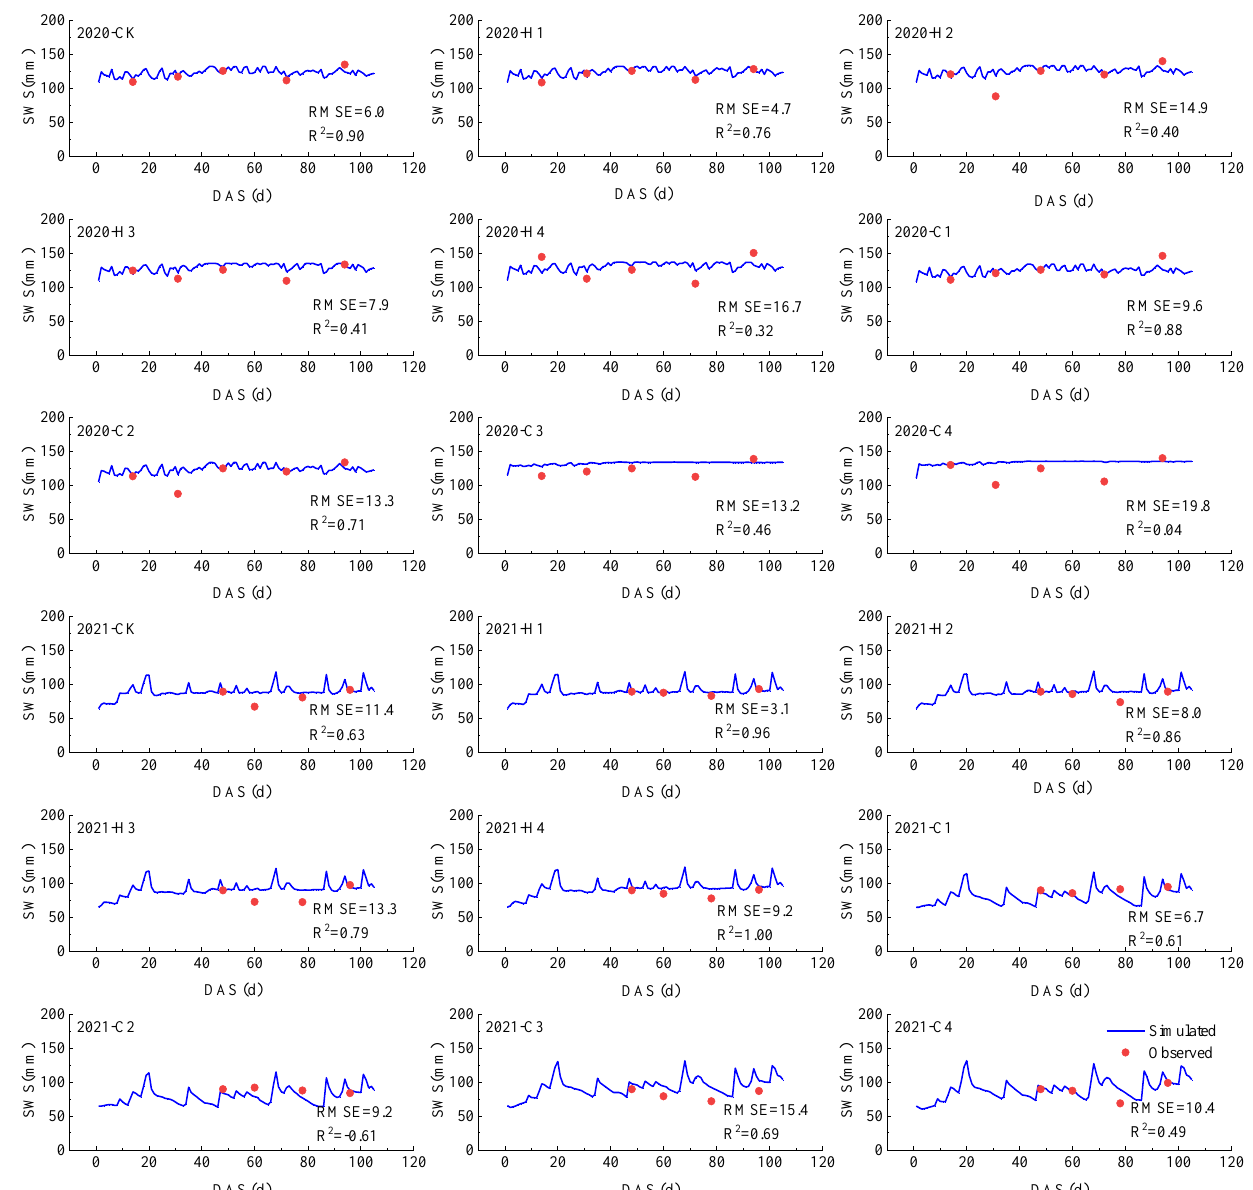
Figure 4. Simulation and observation of soil water storage under all treatments during 2020–2021. SWS is the soil water storage and DAS is the days after